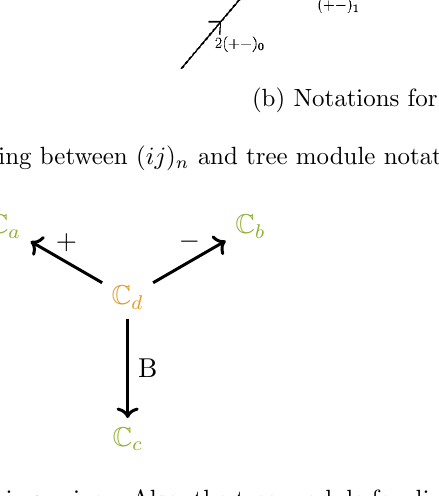
Figure 35. Conventions for the covering quiver. Also, the tree module for dimension vector (1 ;